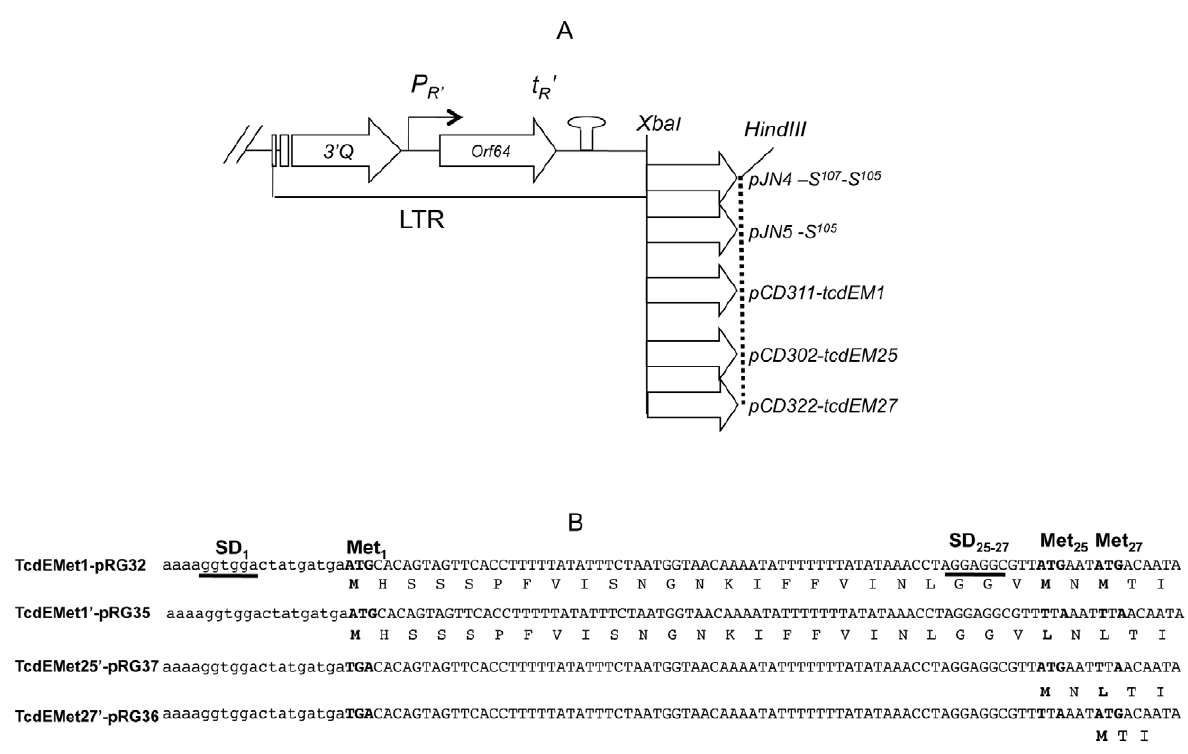
Figure 7. The holin like TcdE. A. Constructs used for holin expression under the control of the late transcription regulatory (LTR) elements of phage l . The promoter p R 9 and the transcriptional terminator t R 9 of the l LTR region are depicted as a bent arrow and a hairpin structure, respectively. B. TcdE sequence: all possible translational starts are indicated as Met 1 , Met 25 and Met 27 , the potential Shine-Dalgarno sequences are underlined and mutated nucleotides in the specified constructs are highlighted in